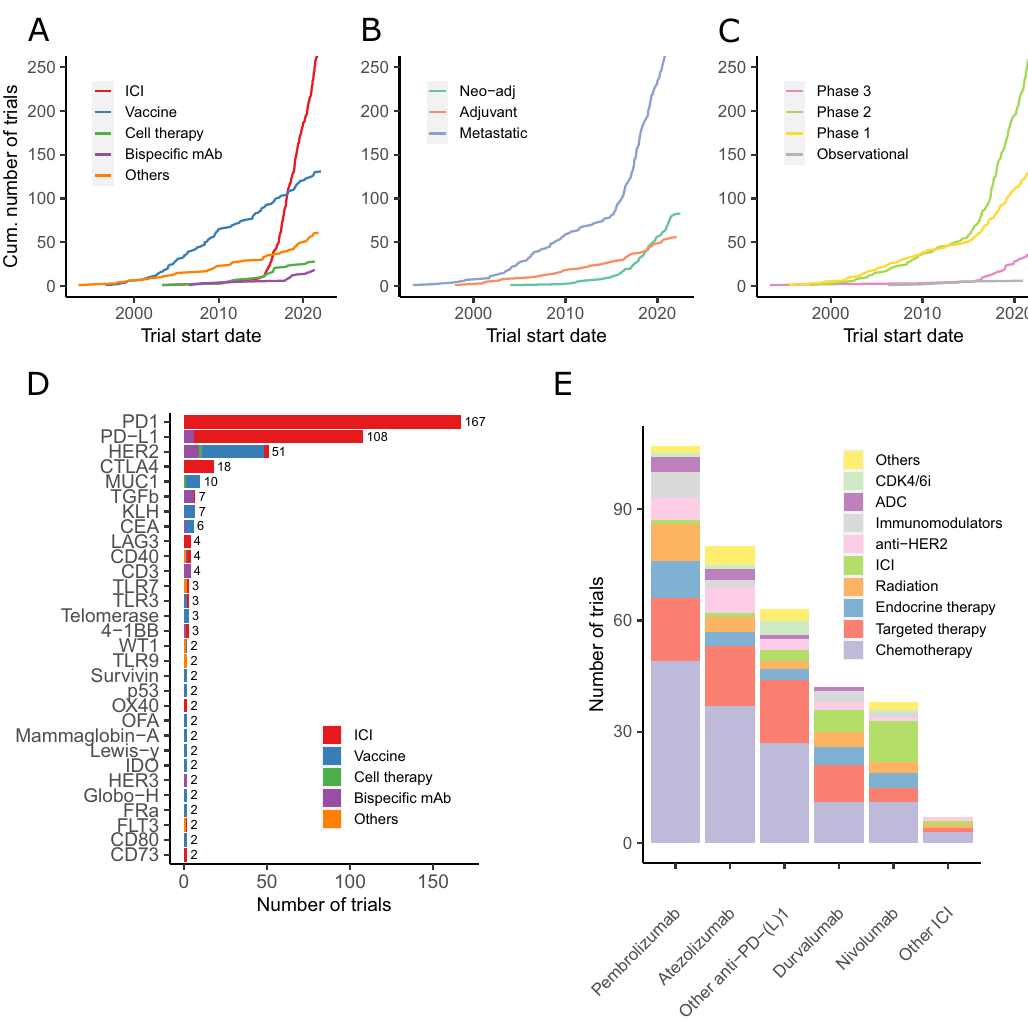
Fig. 1 Immunotherapy trial landscape in breast cancer. Panels A – C show the number of clinical trials in breast cancer since early 2000, by immunotherapeutic approach ( A ), by trial setting ( B ), and by trial phase ( C ). Panel D shows the major immune targets. Only targets present in two or more trials are represented. The complete list of targets is available in online Supplementary Table 1. Panel E shows the histogram of combination trials with PD-1/PD-L1 ICI backbone. ADC antibody-drug conjugates, ICI immune checkpoint inhibitors, mAbs monoclonal antibodies, Neo-adj